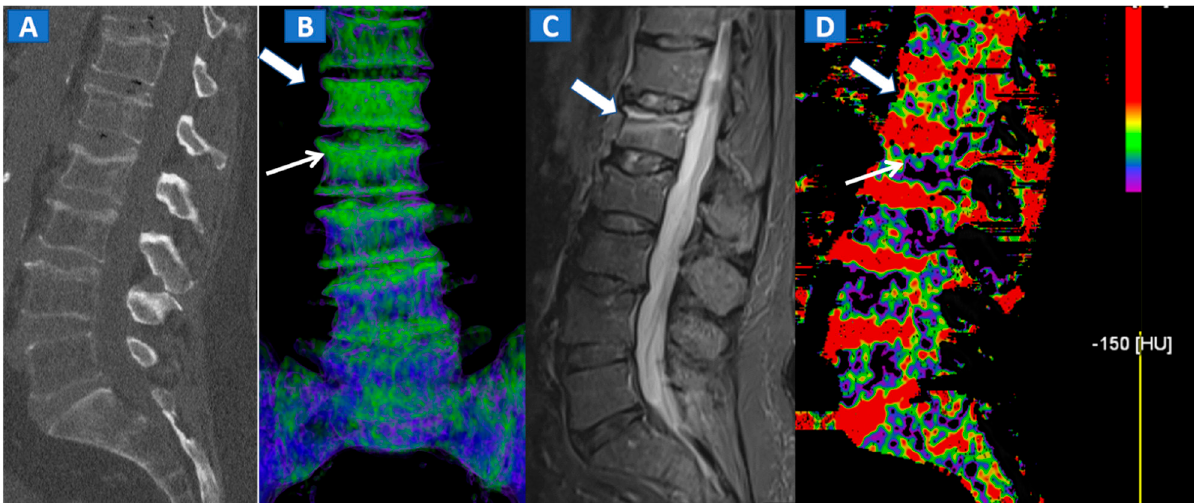
Figure 2. A 62-year-old female with traumatic low back pain following a fall. On the sagittal standard 1 mm CT image ( A ) it is not possible to identify the fresh fracture. On the coronal 3D DECT image ( B ), BME of the L1 vertebral body is coded in green (thick arrow), with some mild oedema depicted on the L2 superior endplate (thin arrow). On the sagittal STIR MRI image ( C ), a fresh fracture of the L1 body is confirmed, with mild oedema located close to the superior endplate (thick arrow). There is no BME of the L2 body apparent on the STIR MRI image. On the corresponding 2D DECT image ( D ), the maximum level of superimposition of color-coded maps was used to confirm the presence of mild oedema on the L1 vertebral body (thick arrow) and to rule out the presence of significant oedema on the L2 body (thin arrow), thus avoiding a false positive finding.